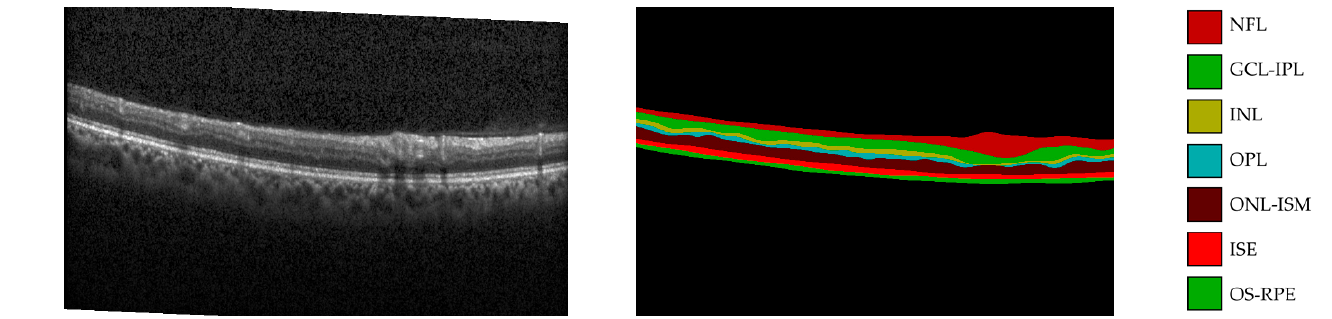
Figure 1. fundus OCT intraretinal layer segmentation. Figure 1. Fundus OCT intraretinal layer segmentation.